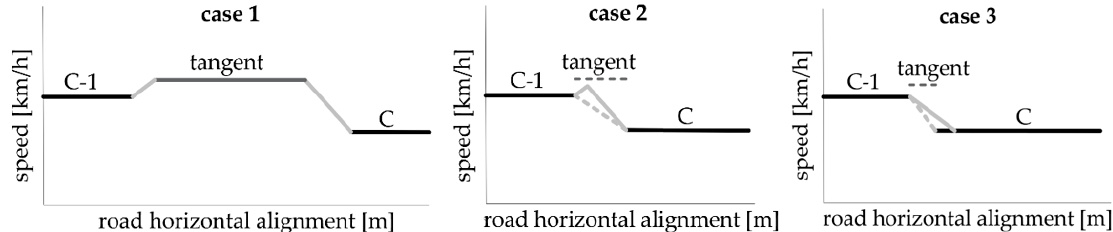
Figure 2. Three cases considered for acceleration/deceleration depending on the road horizontal alignment and related speed measures.